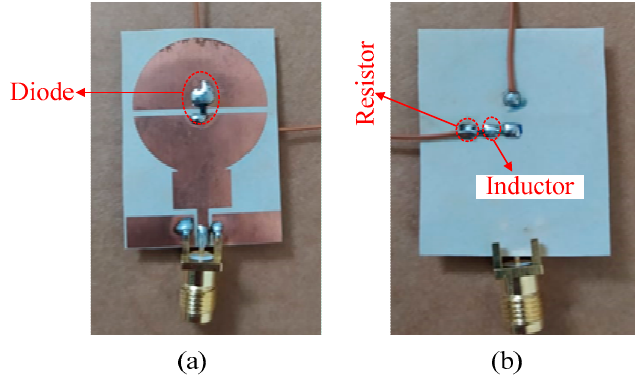
Figure 6. Fabricated prototype: ( a ) top-view and ( b ) bottom view.